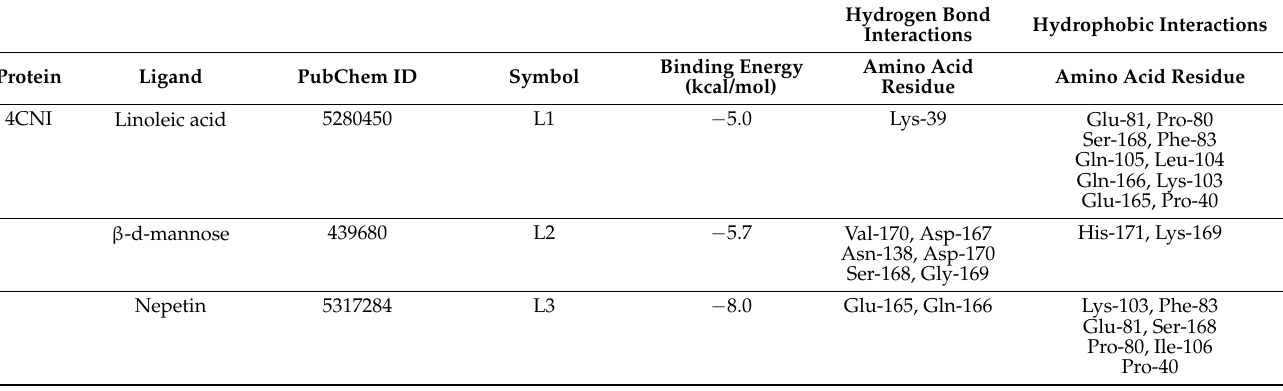
Table 5. Binding energy of potential active compounds on IL6 (PDB ID: 4CNI).